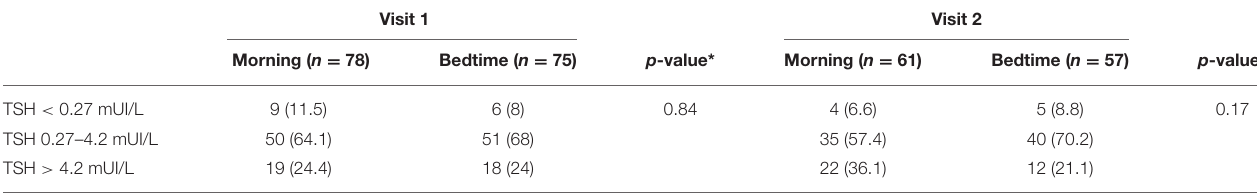
TABLE 3 | Hypothyroidism control status according to LT4 intake